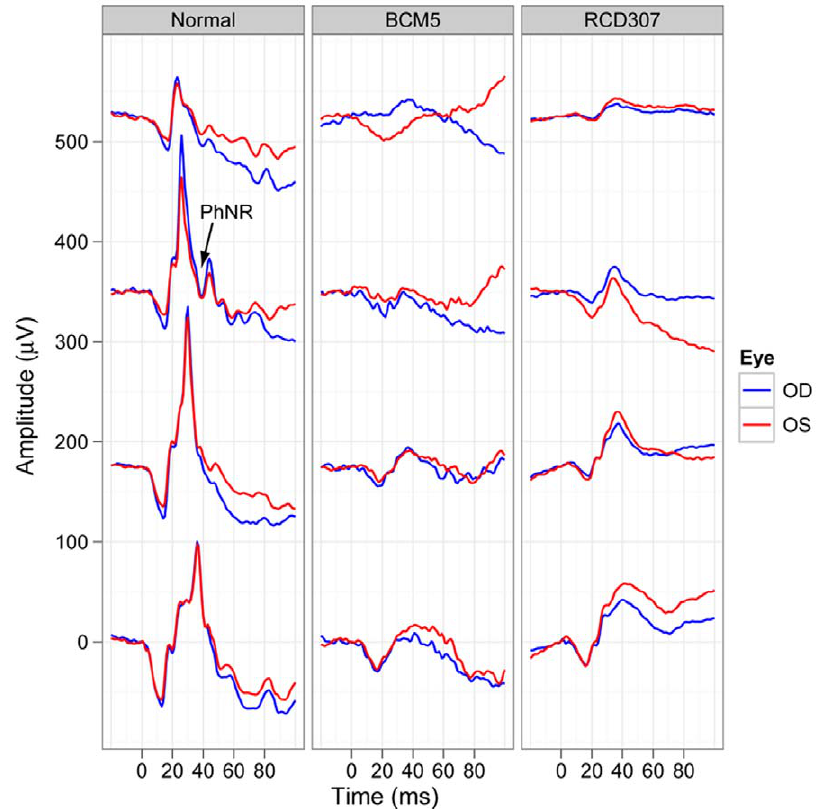
Figure 9. Photopic negative response (PhNR). Photopic single flash response waveforms illustrating the photopic negative response (PhNR) at increasing stimulus intensities (from top to the bottom in each panel) are shown in a normal subject (on the left) and the waveforms of two representative patients of the ALP (patient BCM5 in the middle) and NOP group (patient RCD307 on the right). Notice, that patients lack the PhNR in the given intensity range.